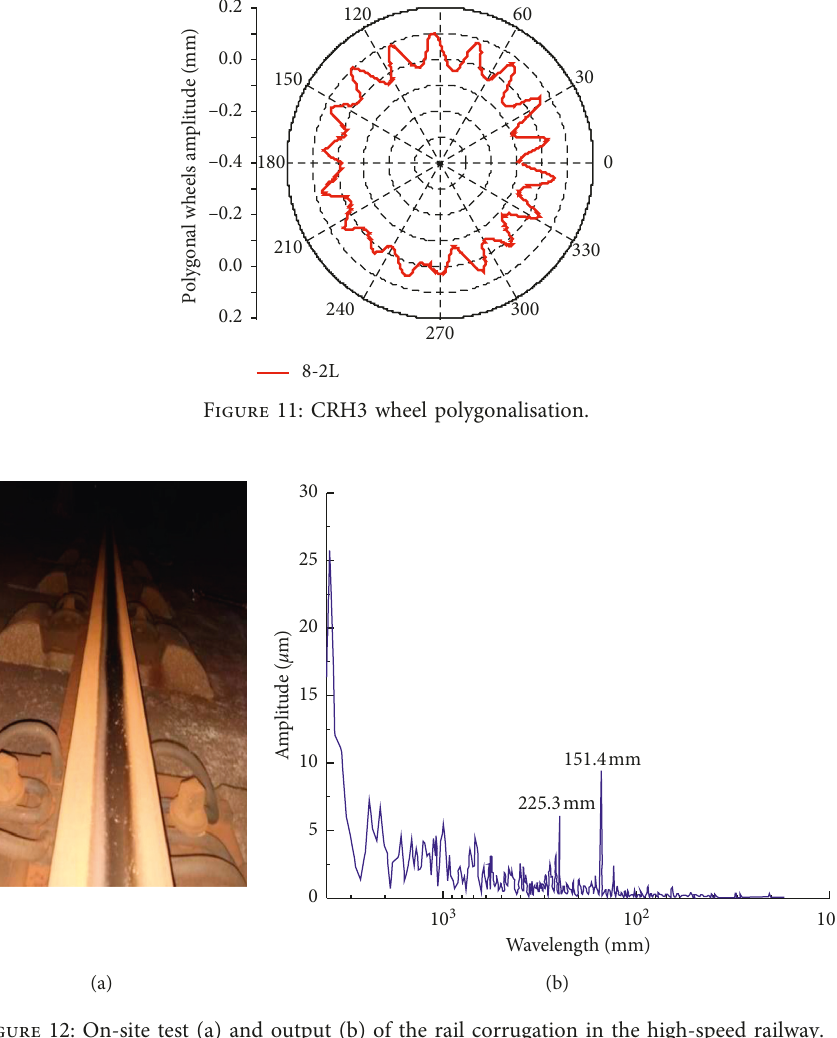
Figure 12: On-site test (a) and output (b) of the rail corrugation in the high-speed railway.